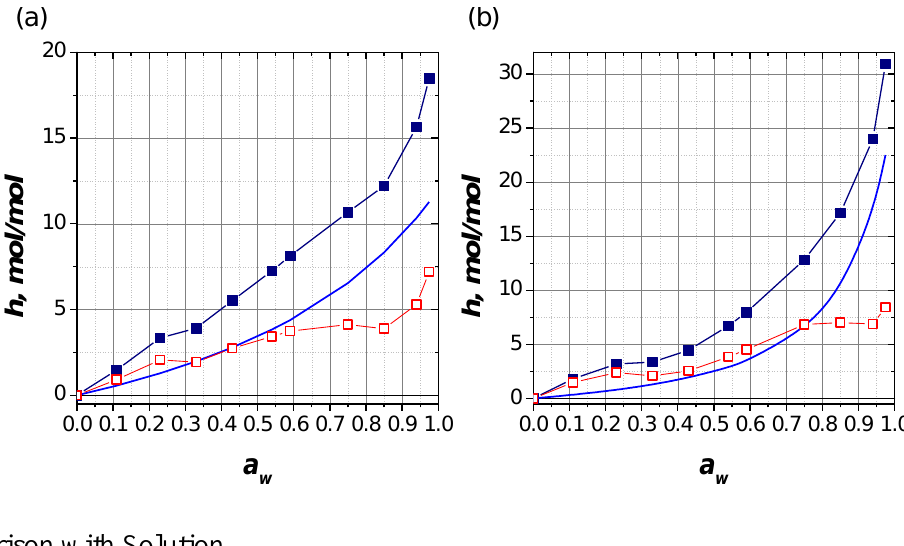
Figure 7. ( a ) Experimental isotherm of water sorption on AMP (filled squares), the calculated isotherm following Flory-Huggins model (solid line) and the difference between the experimental and theoretical dependencies (empty squares). And ( b ) The same data for